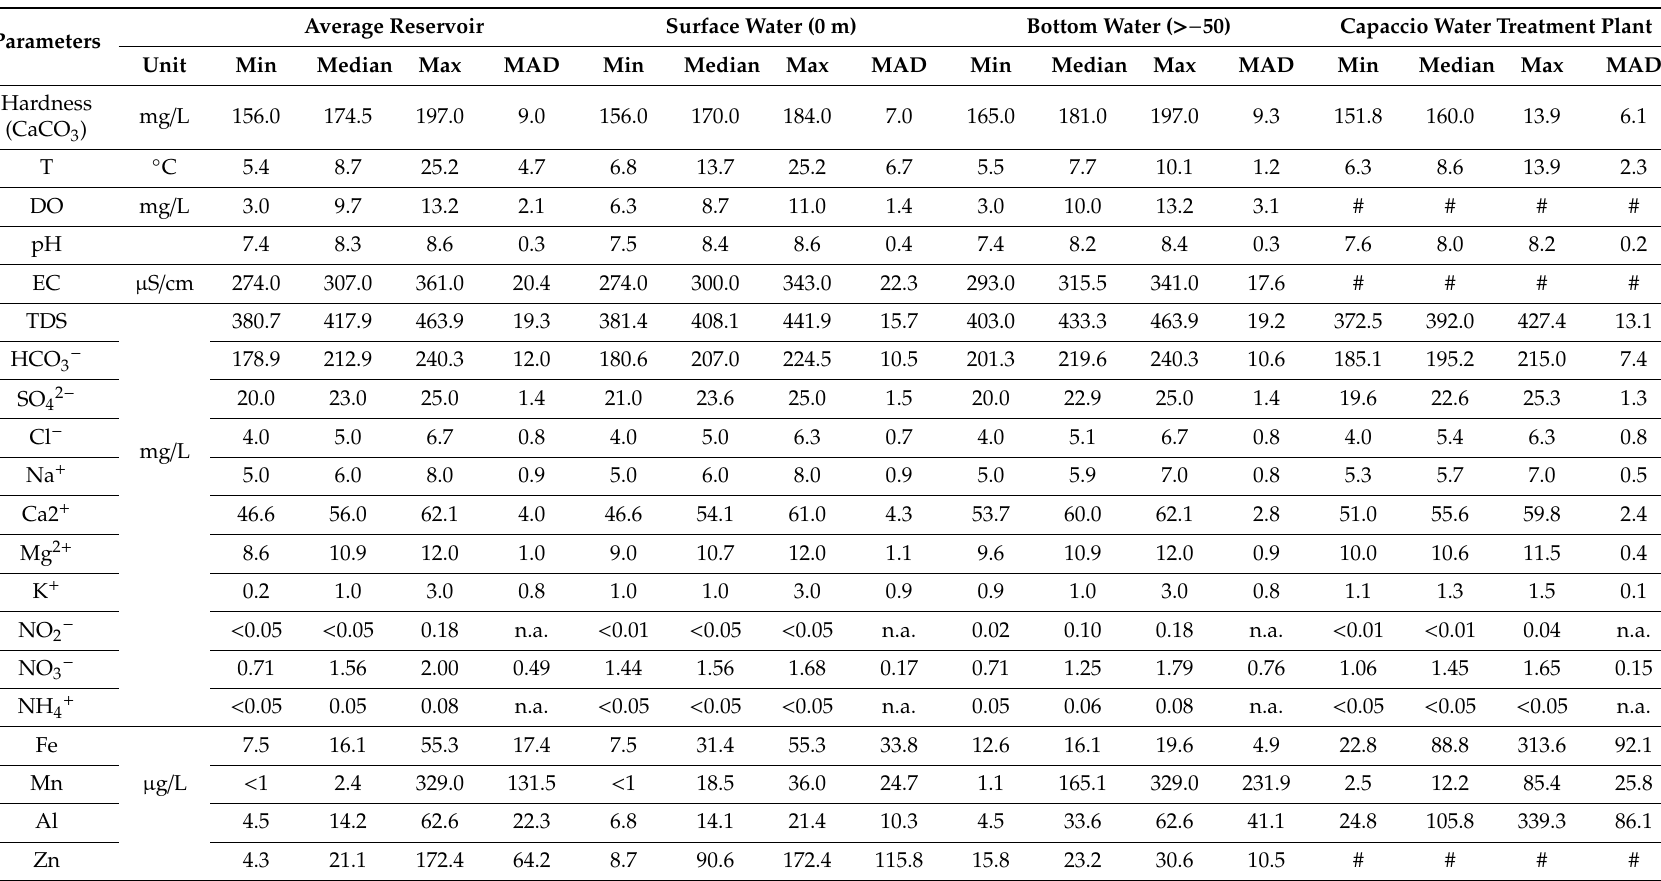
Table 2. Descriptive statistics (minimum, median, maximum, and median absolute deviation—MAD) of all water samples collected in the Ridracoli reservoir and Capaccio water treatment plant. The first group refers to all water samples collected in the reservoir, while second and third groups refers to the same water samples but divided into surface and deep samples, respectively. (To be noted: DO, EC, and Zn values of Capaccio water samples are missing because not measured; MAD values are missing (‘n.a.’ in table) for samples with the majority of concentrations below detection